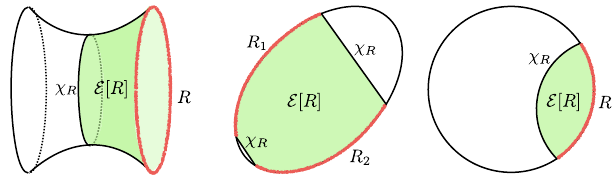
FIG. 1. Geometric notions of minimal surface and entangle- ment wedge. In each diagram, we highlight a boundary region R with a crayon stroke; the corresponding minimal surface χ R is indicated, and the entanglement wedge E ½ R (cid:2) is shaded in green. On the left, B is a hyperboloid whose boundary ∂ B has two connected components, where R is one of those components (the one on the right). The minimal surface cuts the hyperboloid at its waist, and the entanglement wedge is everything to the right of χ R . In the central diagram, B is the interior of a Euclidean ellipse; the boundary region R ¼ R 1 ⊔ R 2 has two connected components, and χ R also has two connected components. As shown, the connected components of χ R need not be homologous to R 1 and R 2 , allowing E ½ R 1 ⊔ R 2 (cid:2) to be significantly larger than E ½ R ⊔ E ½ R B is the Poincaré disc, portraying an 1 (cid:2) 2 (cid:2) . On the right, infinite hyperbolic geometry. The minimal surface is a geodesic in the bulk with end points on ∂ B